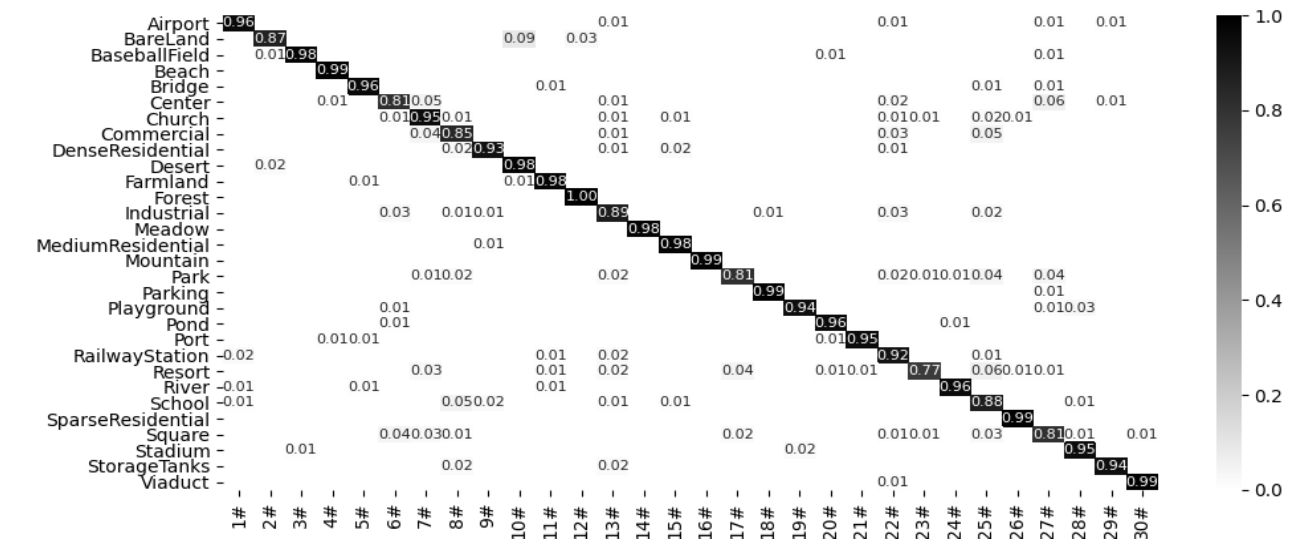
Figure 11. Confusion matrix of the proposed method on the RSSCN7 dataset.